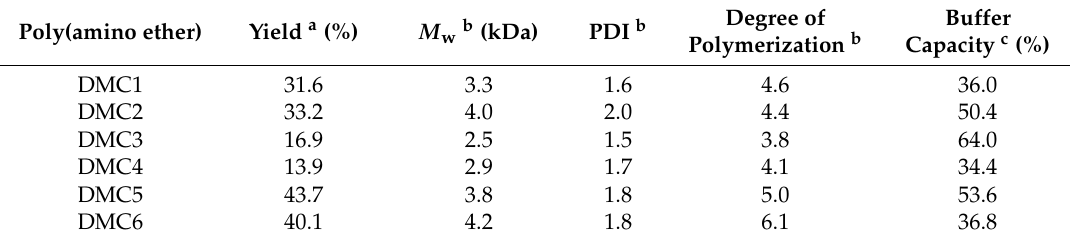
Table 1. Characteristics of linear bioreducible poly(amino ether)s prepared through the reaction of N , N (cid:48) -dimethylcystamine (DMC) with different diglycidyl ethers (1–6). Poly(amino